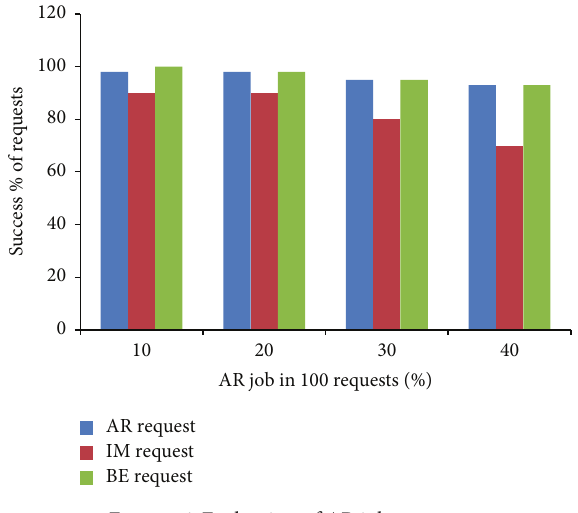
Figure 6: Evaluation of AR job requests. Table 1: Values assigned in simulation.